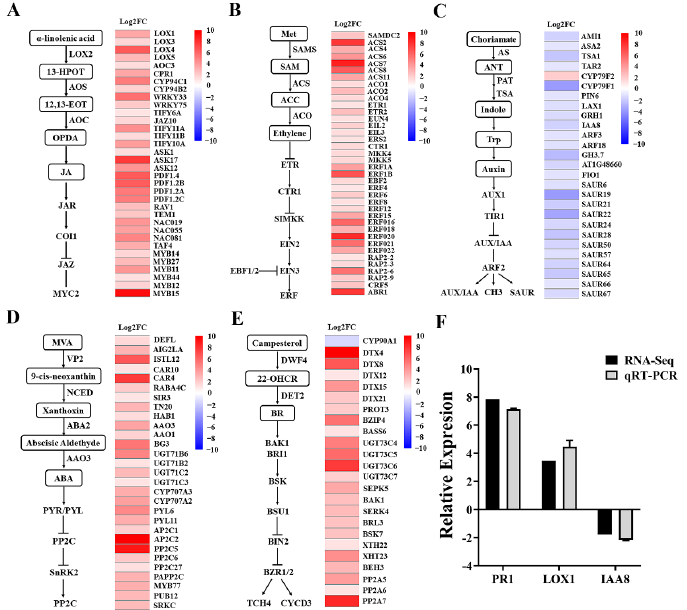
Figure 6. Fold changes in gene expression of major plant hormone signallingsignaling pathways by mycosubtilin treatment. After 12 h treatment with mycosubtilin in Arabidopsis: ( A ) JA signaling pathway fold change in gene expression; ( B ) ET signaling pathway fold change in gene expression; ( C ) IAA signaling pathway fold change in gene expression; ( D ) ABA signaling pathway fold change in gene expression; ( E ) BR signaling pathway fold change in gene expression; and ( F ) transcriptome data qRT-PCR verification.